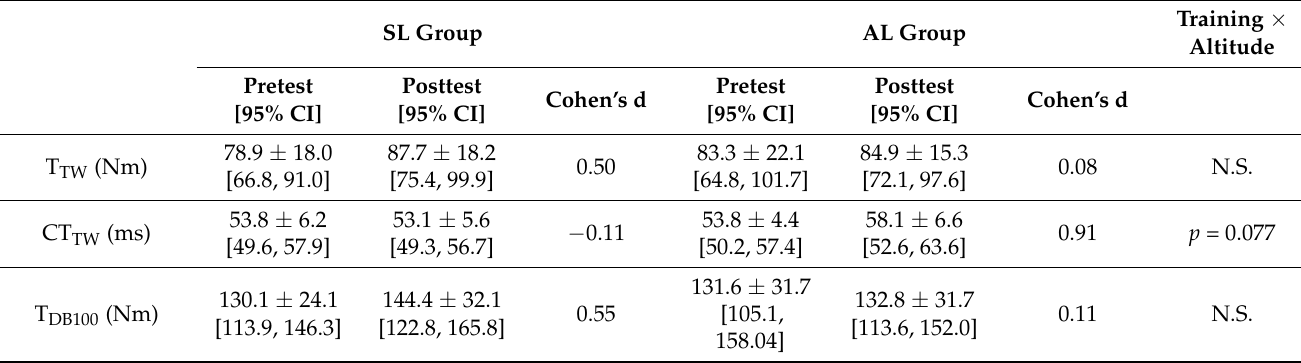
Table 6. Contractile properties of the quadriceps before and after explosive and endurance strength training in elite judo